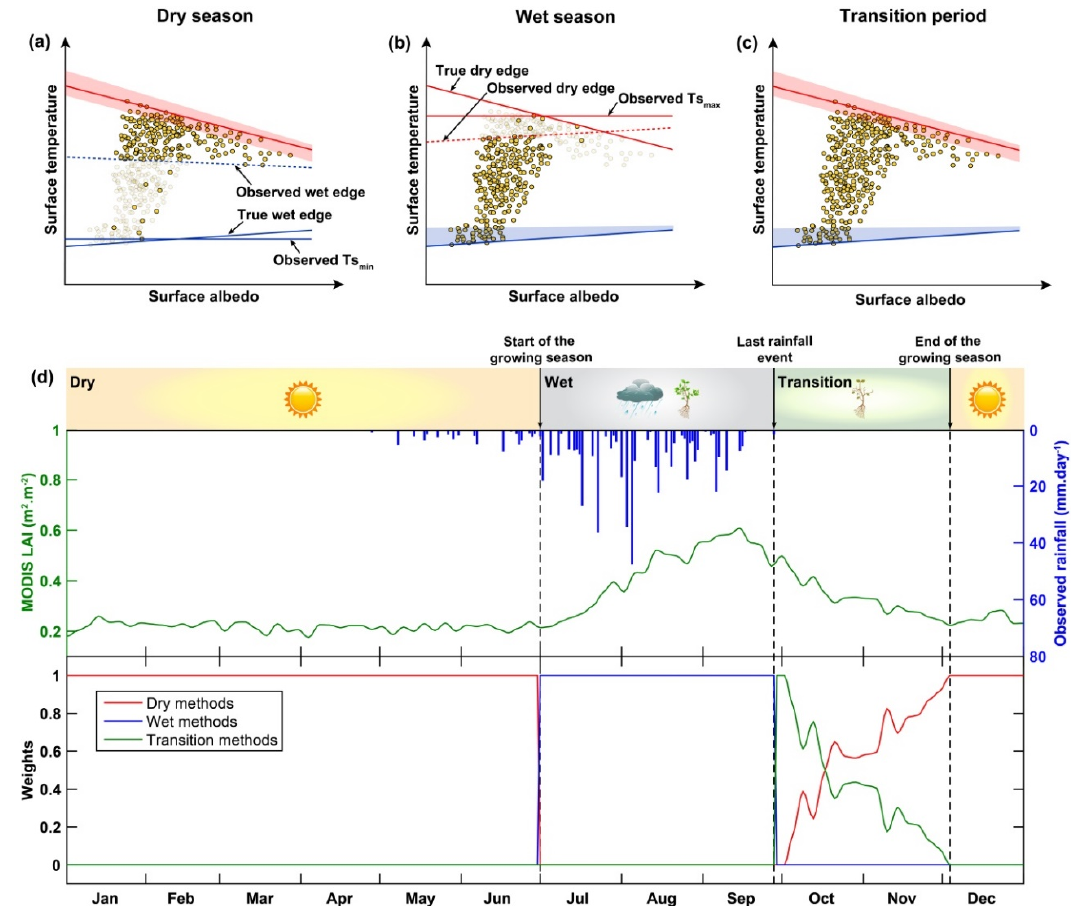
Figure 4. Typical configurations of the Ts- α scatterplot during ( a ) the dry season, ( b ) the wet season, and ( c ) the transition period. ( d ) Partitioning of the year 2007 into the three periods, based on leaf area index (LAI) and rainfall (top), and variations of weights for the three classes of associated edges determination methods